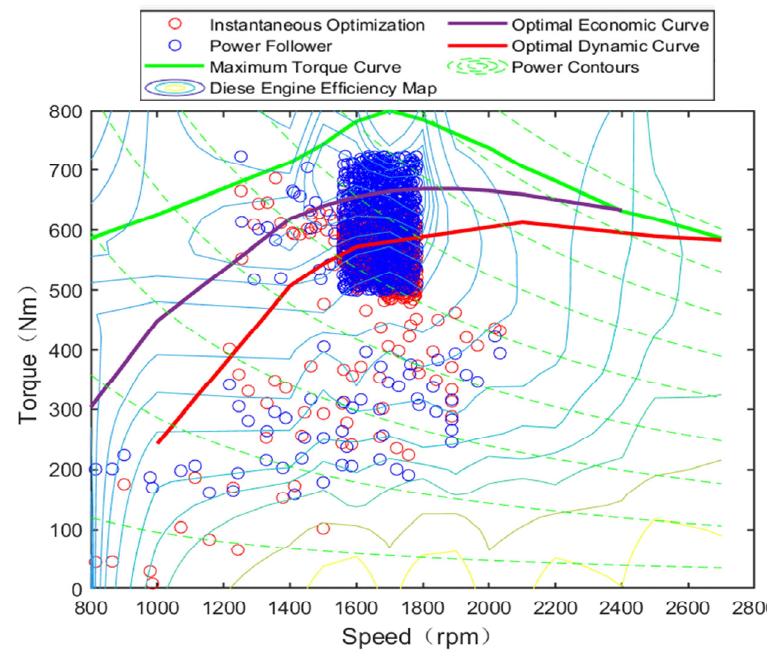
Figure 21. Diesel engine operating points.